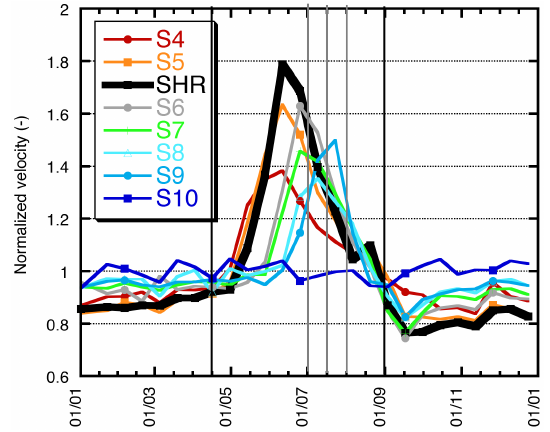
Figure 3. The average seasonal cycle of the velocity at stations S4– S10 over the last 7 years. Data are normalized with their mean over the entire period with data available. Note the progressive increase in velocity over winter at SHR. Higher frequency cycles after the summer peak are smoothed by a 2-week-long period filter. The grey lines show the arbitrary range in the separation between early and late summer. Qualitative conclusions are not affected by the arbi- trary choice of this date.